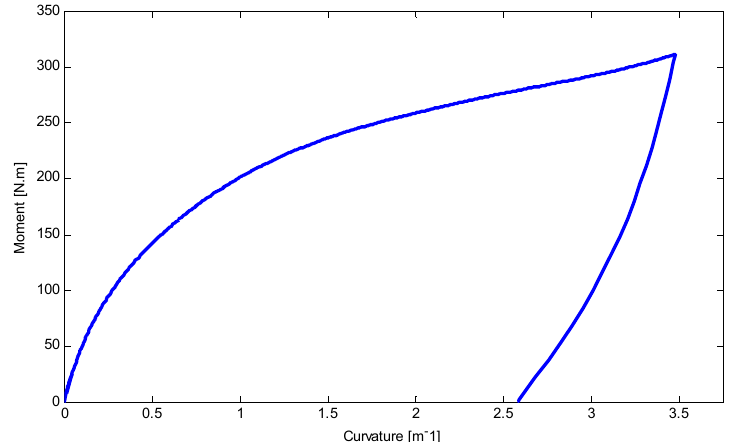
Figure 23. Curvature and moment relationship for the circular SMA beam subjected to four-point bending test with the force about 19 kN at room temperature.